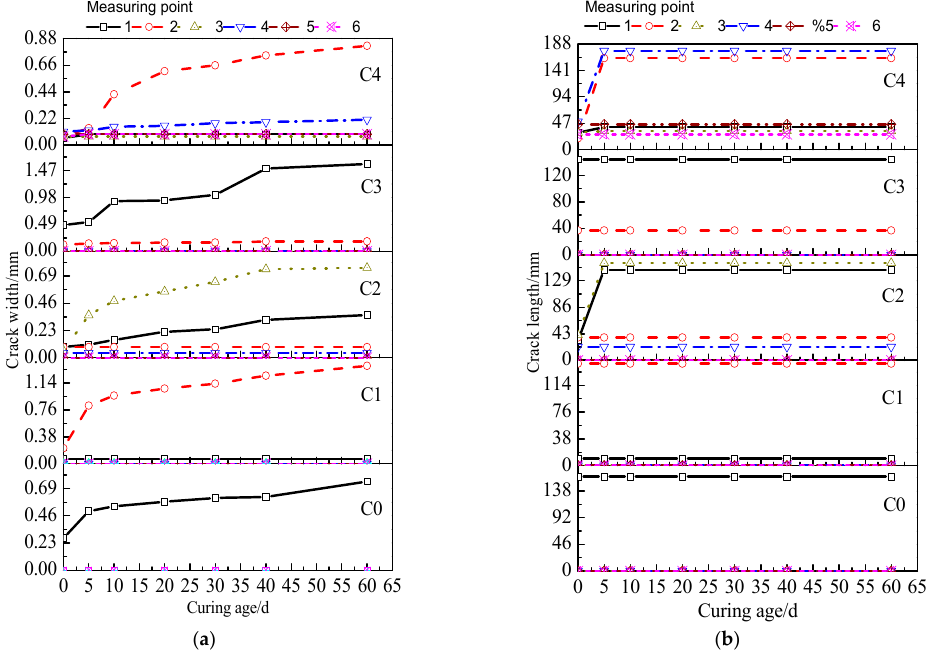
Figure 12. Relationship between crack width, crack length, and curing age of the NCM ring. ( a ) Crack width; ( b ) crack length. From the observation of the NCM rings in each group,we see the relationship be- tween the maximum crack width, the maximum crack length, and the post-cracking age,asshown in Figure 13. Between0–10days, the maximum crack width of each group of specimens increases rapidly. After 10–60days, the growth rates of the ordinary cement mortar, NMA-1, and NMA-2 rings decrease significantly, while the growth rates of NMK-1 and NMK-3 decrease slightly, but the growth rates are still significant.